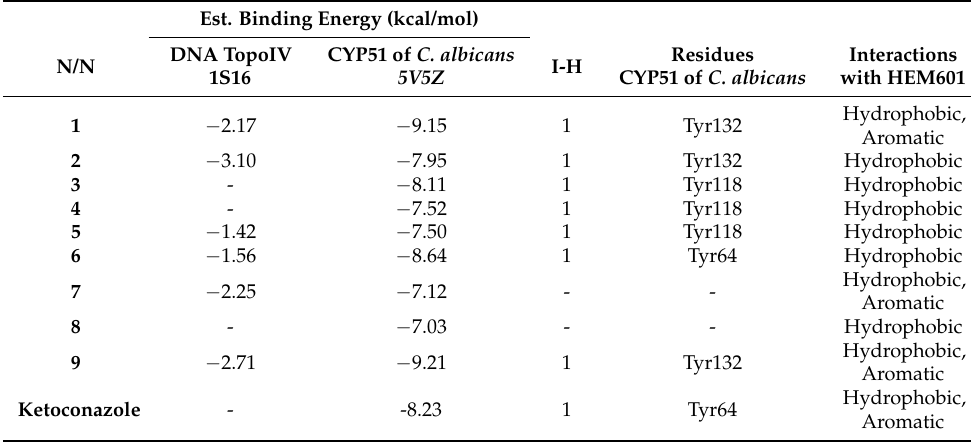
Table 5. Molecular docking free binding energies (kcal/mol) to antifungal targets.